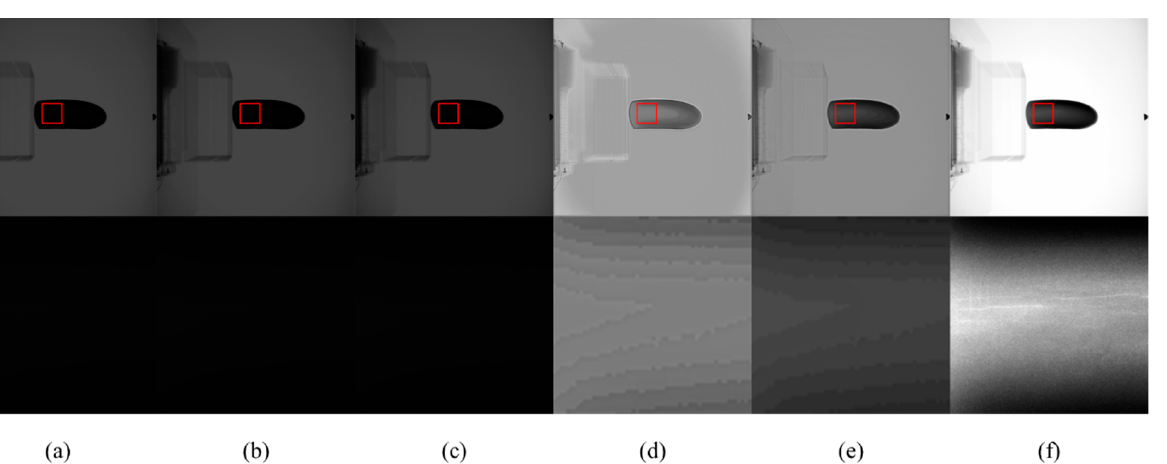
Figure 14. The contrast enhancement results of different methods. Top: raw image and the enhance- ment results; bottom: zoomed-in views on the highlighted area. ( a ) The raw images; ( b ) CLAHE; ( c ) LCM-CLAHE; ( d ) Retinex-Net; ( e ) Zero-DCE; and ( f ) our method.